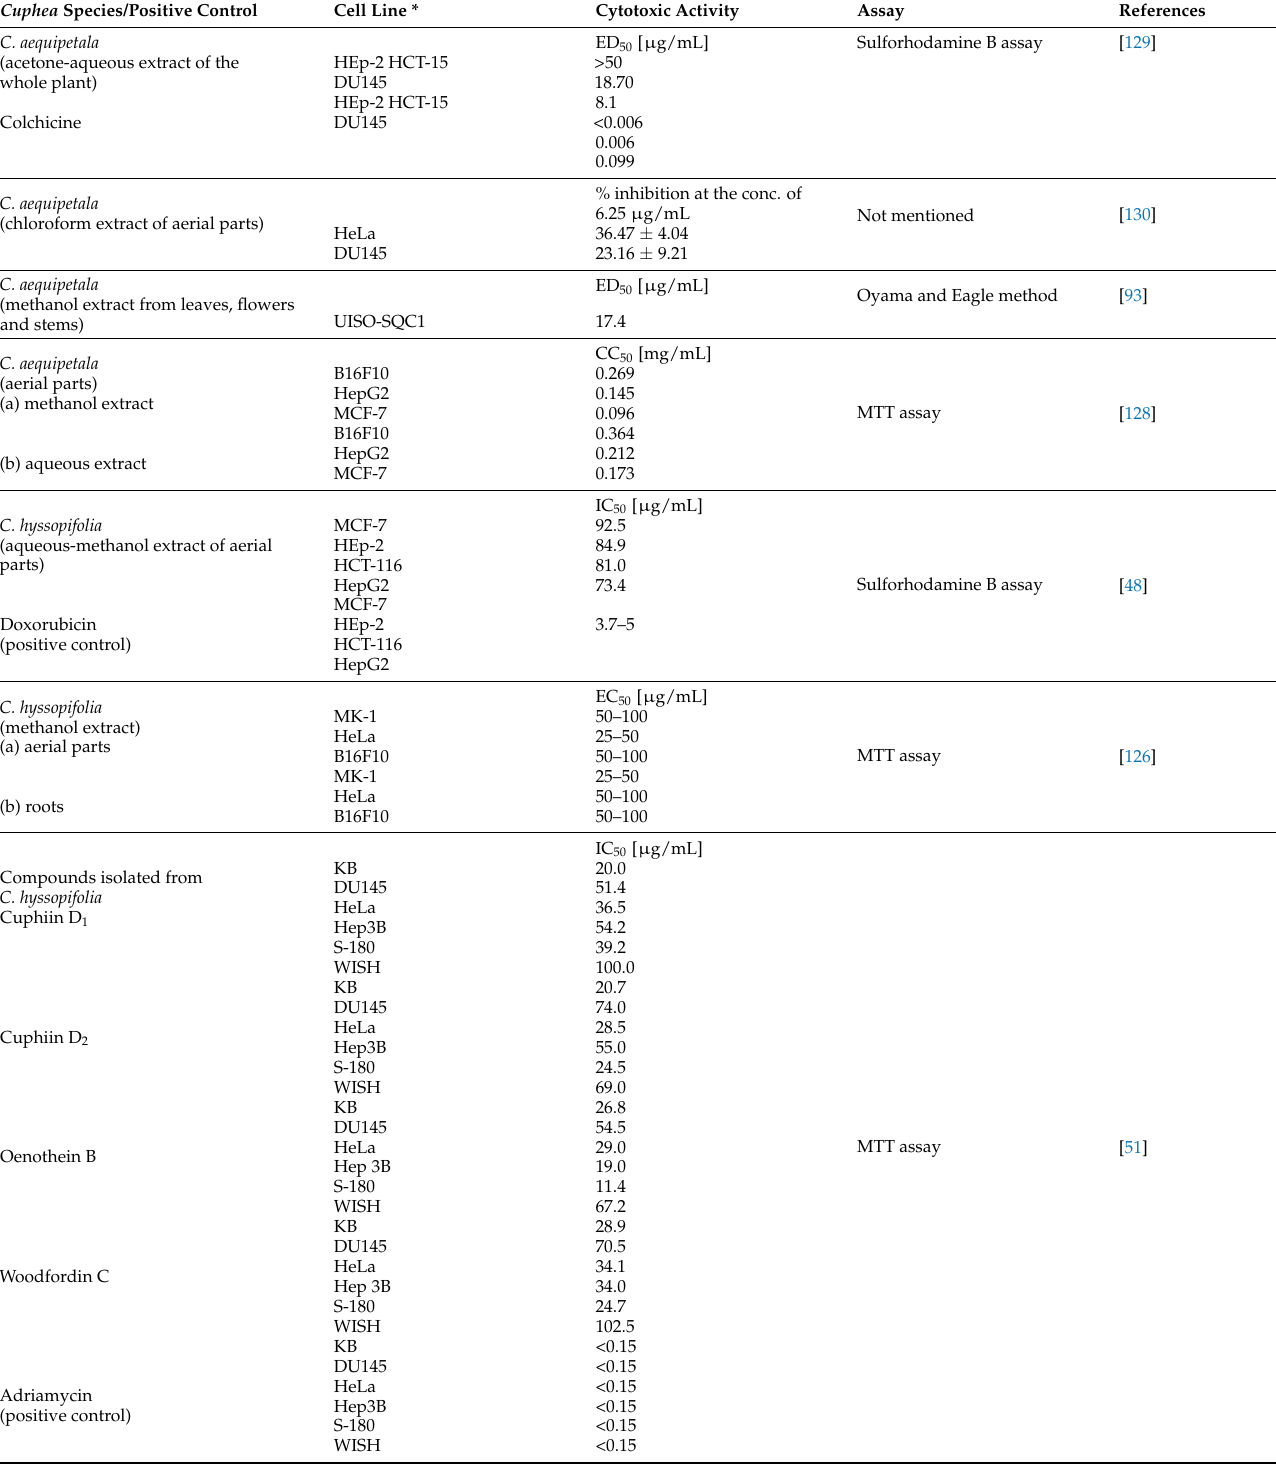
Table 5. In vitro cytotoxic activity of Cuphea